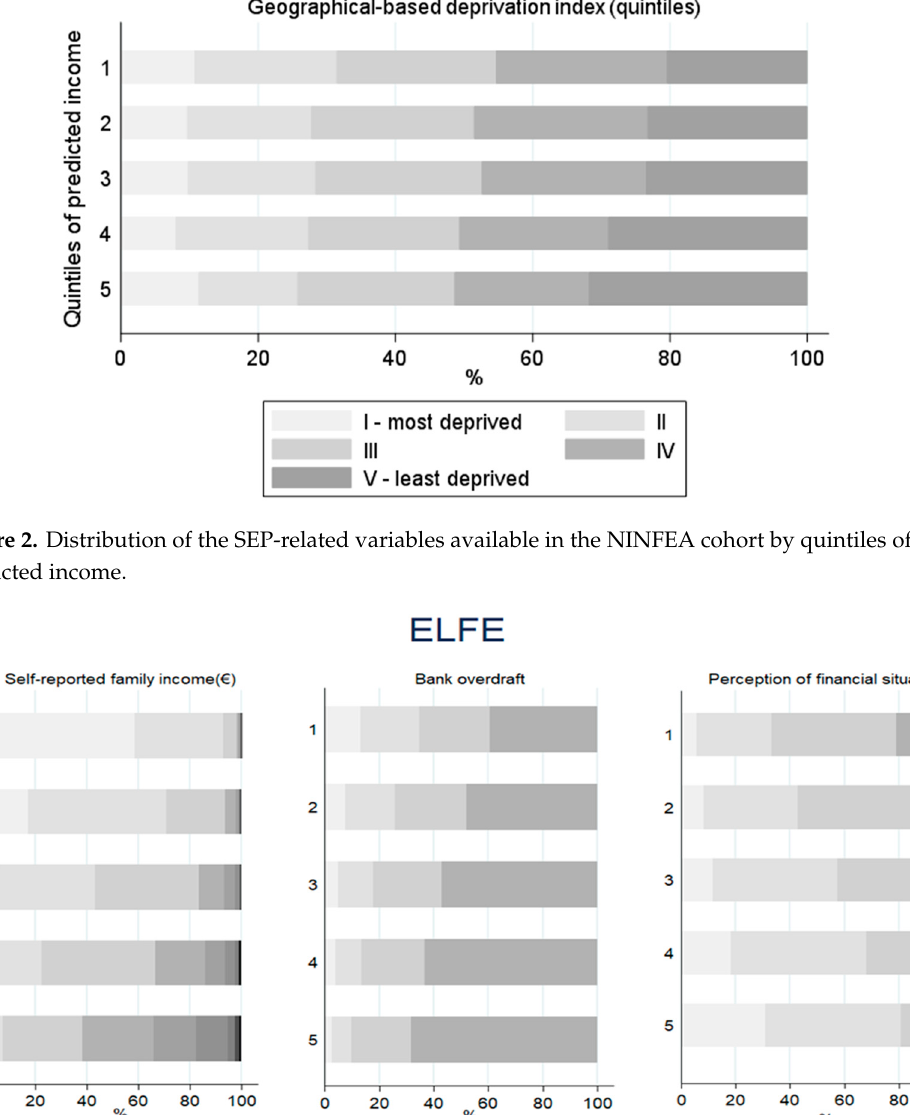
Figure 1. Distribution of the socioeconomic position (SEP)-related variables available in the Piccolipiù cohort by quintiles of the predicted income.